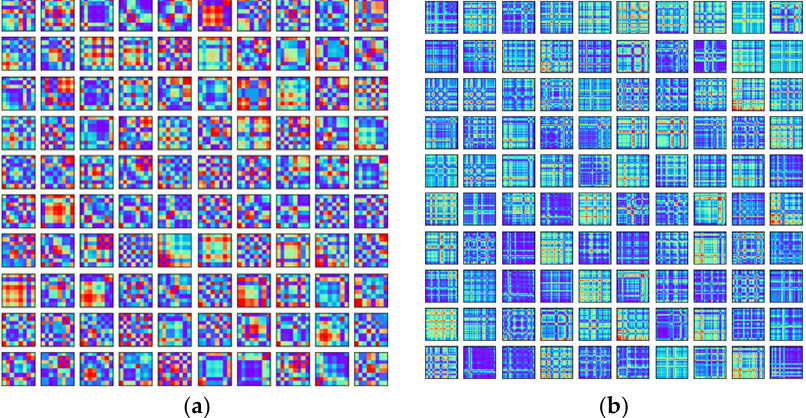
Figure 4. Illustration of the GAF image for 100 rows of normalized ( a ) WESAD and ( b ) SWELL datasets in the form of a 10 × 10 square matrix.